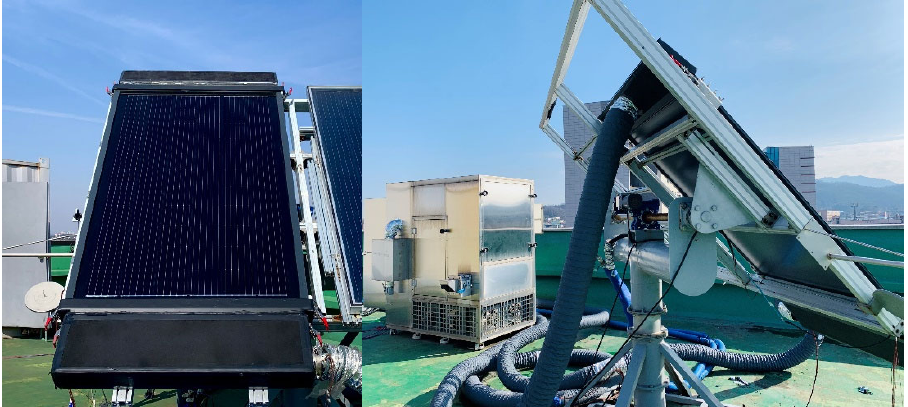
Figure 6. BIPVT collector outdoor experimental setup. Table 6. Instrument